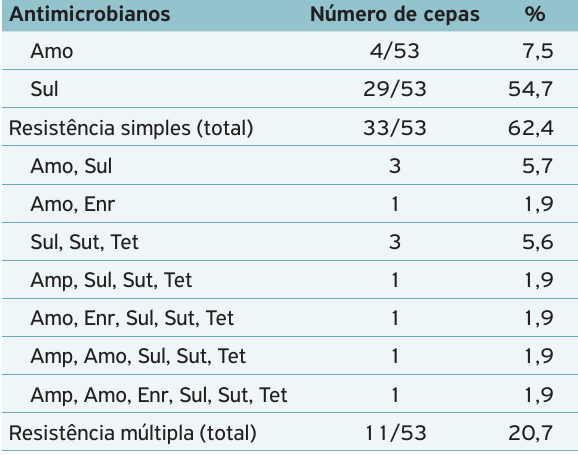
Tabela 4. Perfis de resistência aos antimicrobianos dos isolados de Salmonella sp. de diferentes fontes de